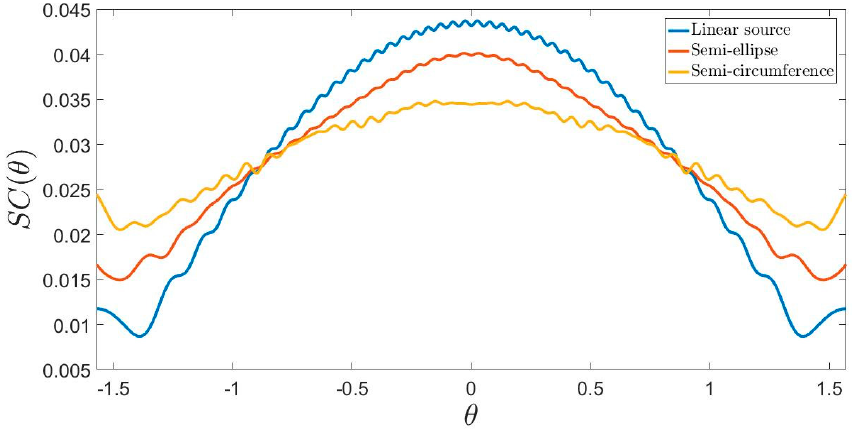
Figure 15. Spectral content functions SC ( θ ) for a linear source (a (cid:48) x = 9.75 λ ), a semi-ellipse (a (cid:48)(cid:48) x = 8.75 λ and a (cid:48)(cid:48) z = 5 λ ), and a semi-circumference (a (cid:48)(cid:48)(cid:48) x = a (cid:48)(cid:48)(cid:48) z = 7.4 λ ) with the same number of significant eigenvalues (N T = 40 ).